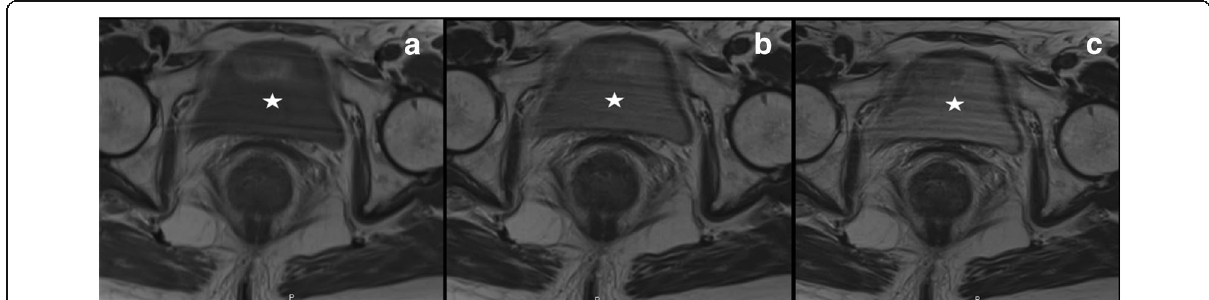
Fig. 3 Axial T2-weighted images of the pelvis, acquired keeping unchanged all the parameters, with only exception of the echo time, which was 34 ms in ( a ), 90 ms in ( b ), and 134 ms in ( c ), showing that even one single parameter can change the signal intensity of tissues and fluids, as clearly depicted by the signal of the bladder (white star), with higher and higher signal intensity from a to b to c